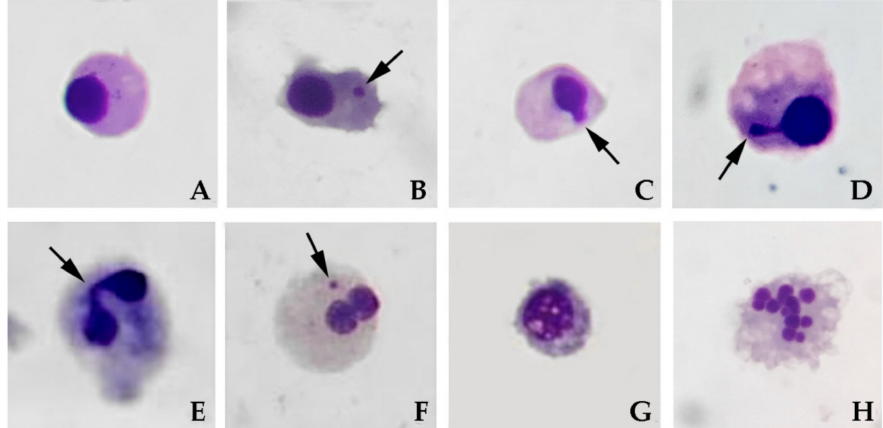
Figure 2. Hemocyte nuclear abnormalities in D. polymorpha . ( A ) Mononucleated healthy cell; ( B ) hemocyte displaying a micronuclei (MN); ( C ) hemocyte with a nuclear bleb (BL); ( D ) hemocyte